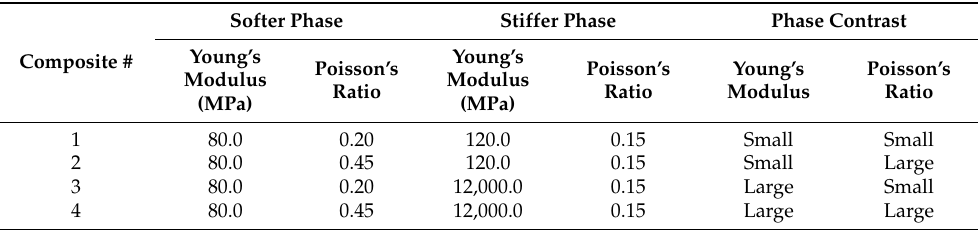
Table 1. Two-phase particulate composites and their phase properties.